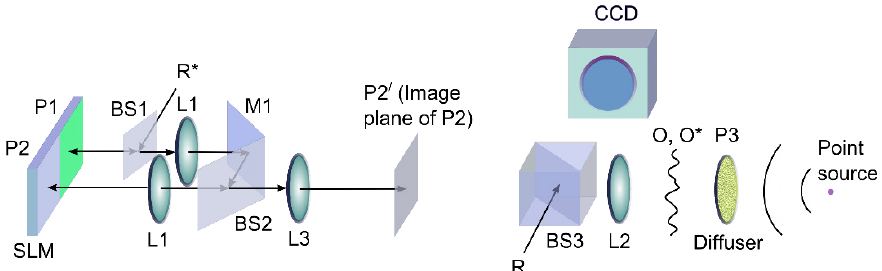
Fig. 3. Proposed optical setup for TR optical focusing through scattering media. O, the object light; O*, the TR object light; R, the reference beam; R*, the conjugated reference beam (reading beam); L, lens; P1 and P2, two identical panels of the SLM; M, mirror; BS, beam splitter. The phase-only SLM is divided into two equivalent panels P1 and P2, which are read out by R* in series. The two identical lenses L1 compose a new complex virtual lens L, whose focal length is equal to half of the optical path between P1 and P2, such that P1 and P2 are the conjugate focal planes of each other. L1 is combined with L3, to compose an imaging system in which P 2 0 is the image plane of P2 (and vice versa), while the magni¯cation ratio precisely matches the ratio between the pixel size of the SLM and